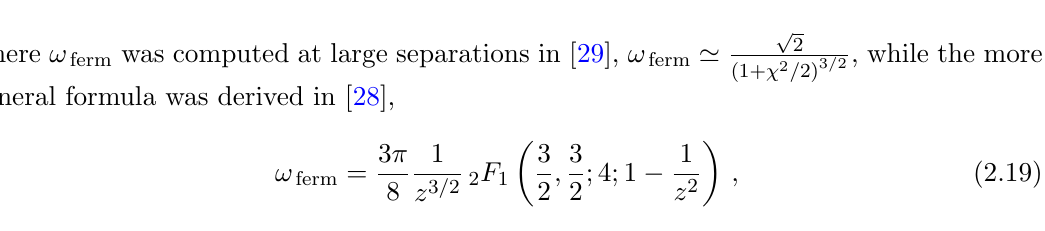
Figure 2 . The plot on the left shows the contribution arising from fermion zero modes ! ferm for a single light (cid:13)avour (solid line). The dashed line is the large separation approximation The plot on the right shows the corresponding contributions to the fermion prefactor K ferm in (2.18) for N f =